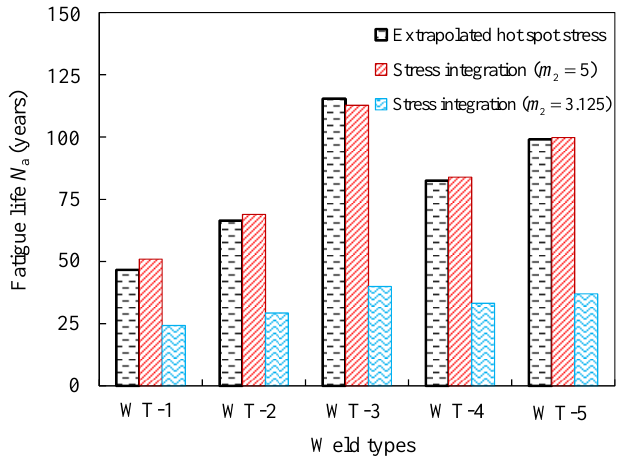
Figure 21. Variation of fatigue life with weld size.